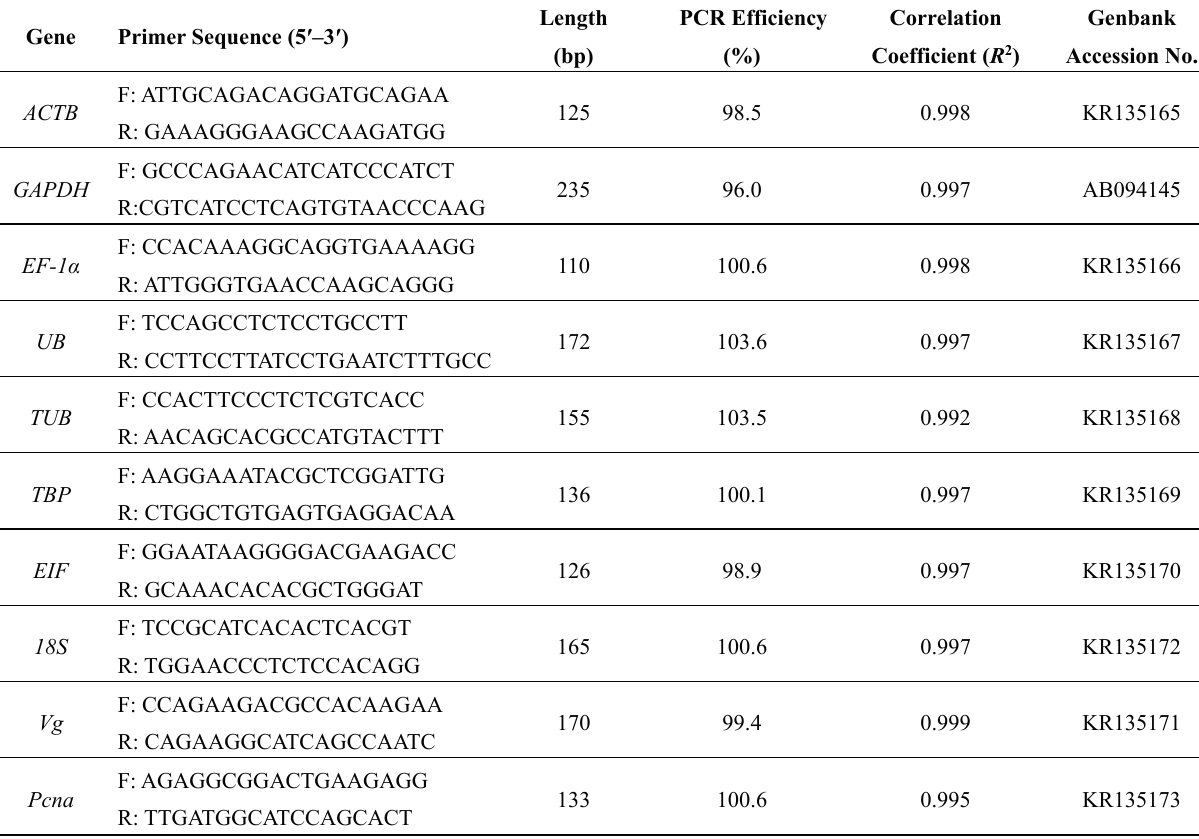
Table 1. Primers and PCR amplification